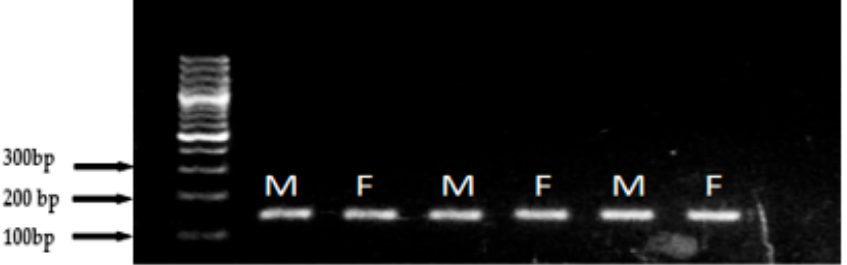
Figure 1. TPD1-like gene ampli fi cation in leaves using date palm suckers’ DNA as template. PCR product was run on 1.5% agarose gel using a 100 bp ladder (Thermo Scientific Inc., Waltham, MA, USA). A band of 152 bps was observed on the gel. M representing male plants while F representing female plants.